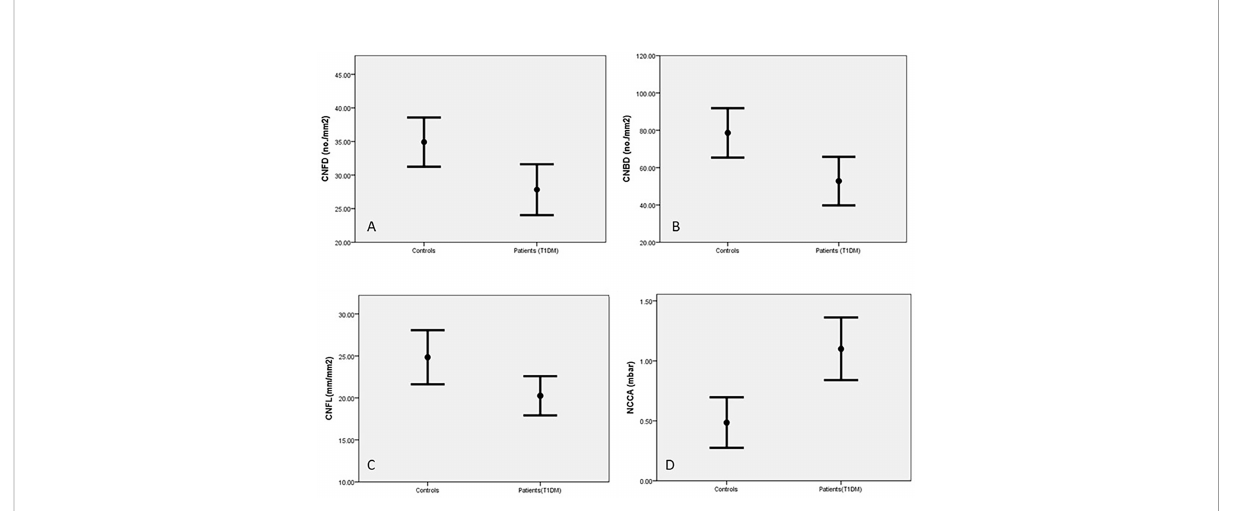
FIGURE 2 Corneal nerves parameters in control subjects and patients with T1DM corneal nerve fi ber density (CNFD) (A) , corneal nerve branch density (CNBD) (B) , corneal nerve fi ber length (CNFL) (C) and Non-contact corneal Aesthesiometry (NCCA) (D) (results are expressed as Mean and